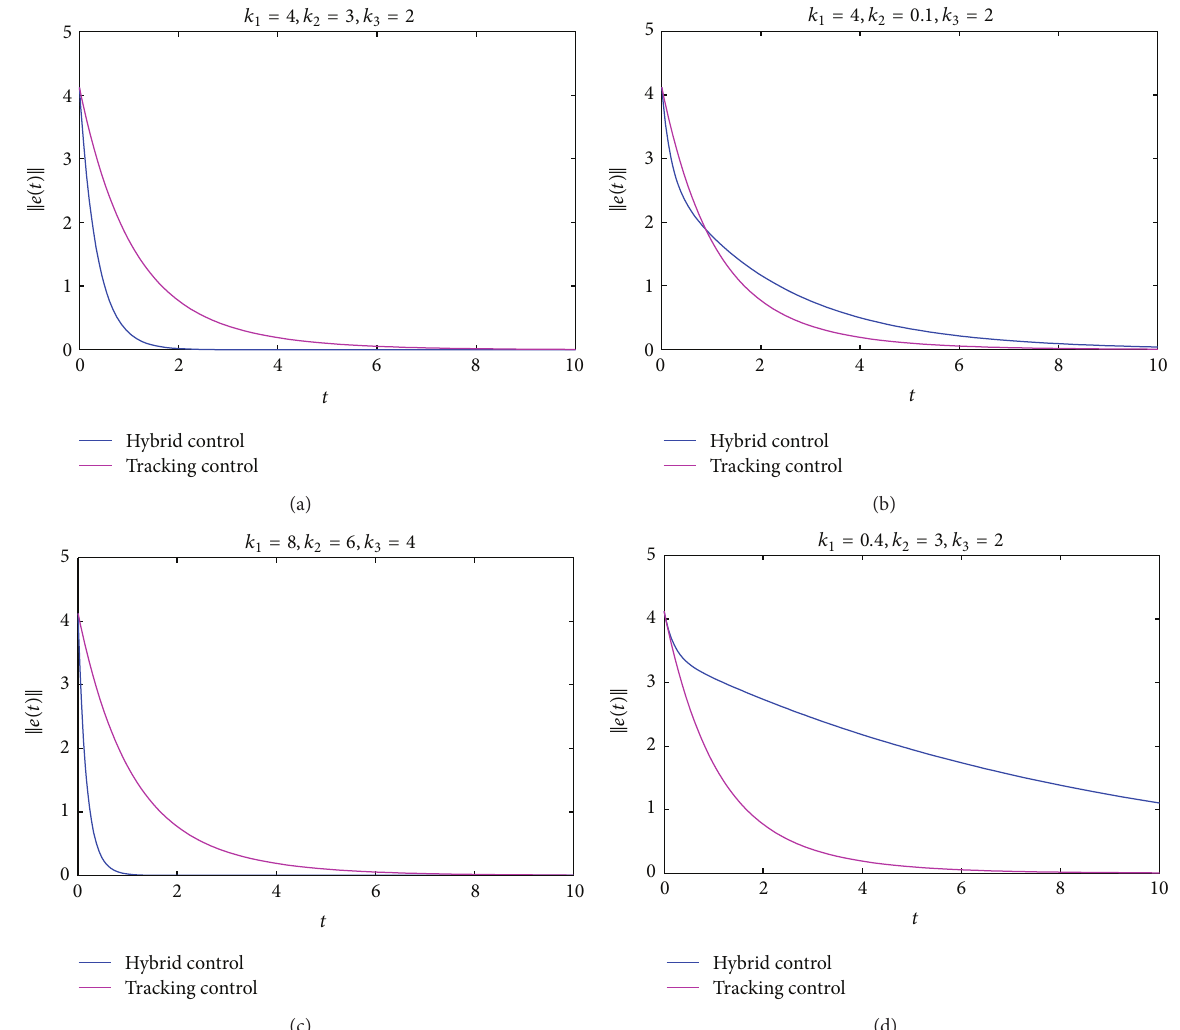
Figure 6: Comparison of the hybrid and the tracking control techniques in the context of chaotic Shimizu-Morioka